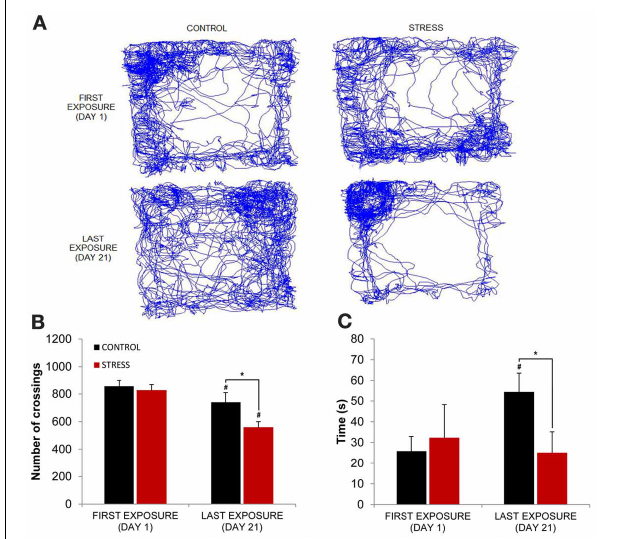
FIGURE 2 | Evolution of behavioral parameters through familiarization from first and last exposures to the OF arena. (A) Representative trajectories from one rat from each group (control left; stress right) between the first (top) and last (bottom) exposures. (B) Comparison of exploratory activity, as measured by the total number of crossings between the squares on which the arena was divided for behavioral analysis, between first (left) and last (right) exposure to the OF arena on control (black bar) and stress (red bar) groups. (C) Comparison of time spent in the center of the OF arena between first (left) and last (right) exposure on control (black bar) and stress (red bar) groups. Rats from both groups significantly decreased exploratory activity between the first and last exposures to the arena, although the observed decrease was five times greater in stress group animals. Control rats significantly increased the time spent in the center of the arena from the first to the last exposure while stressed rats did not. # p < 0 . 05 for paired Wilcoxon sign rank test comparison of behavioral parameters within the same group between exposures; ∗ p < 0 . 05 for unpaired Wilcoxon rank sum test comparison of behavioral parameters between groups on each exposure. Error bars: ±